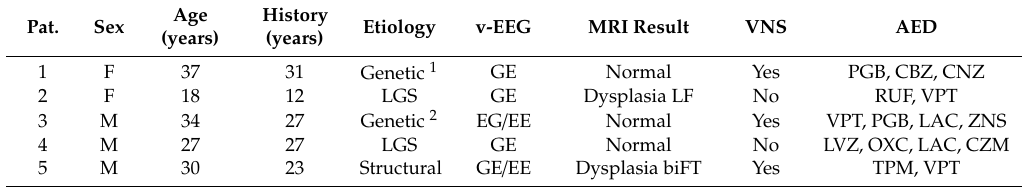
Table 1. Clinical features of the group